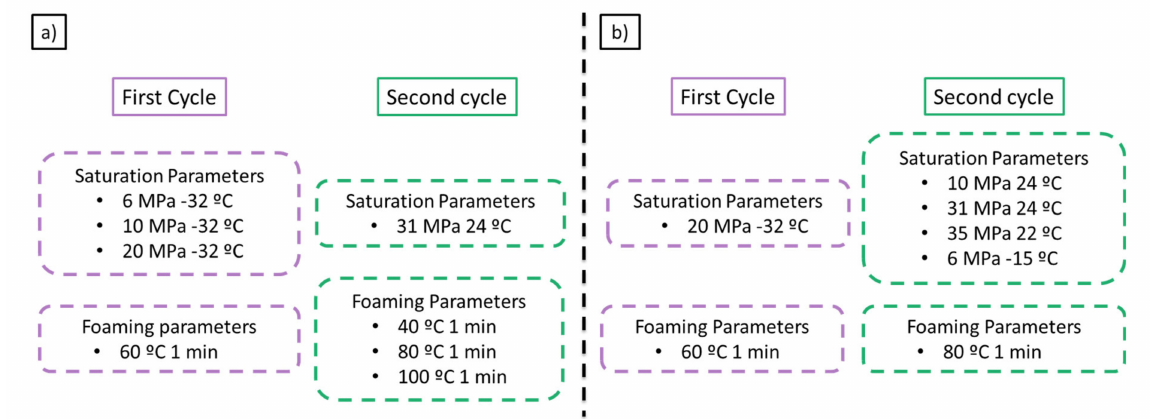
Figure 3. ( a ) Set of experiments to evaluate the effect of the first cycle saturation parameters and the effect of the second cycle foaming parameters on the final cellular structure. ( b ) Set of experiments carried out to evaluate the effect of the second cycle saturation parameters on the final cellular